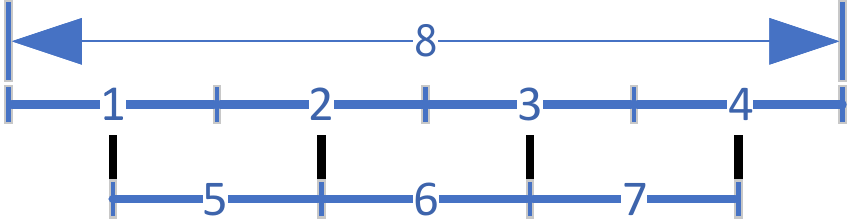
Figure 5. The method of segment for driving